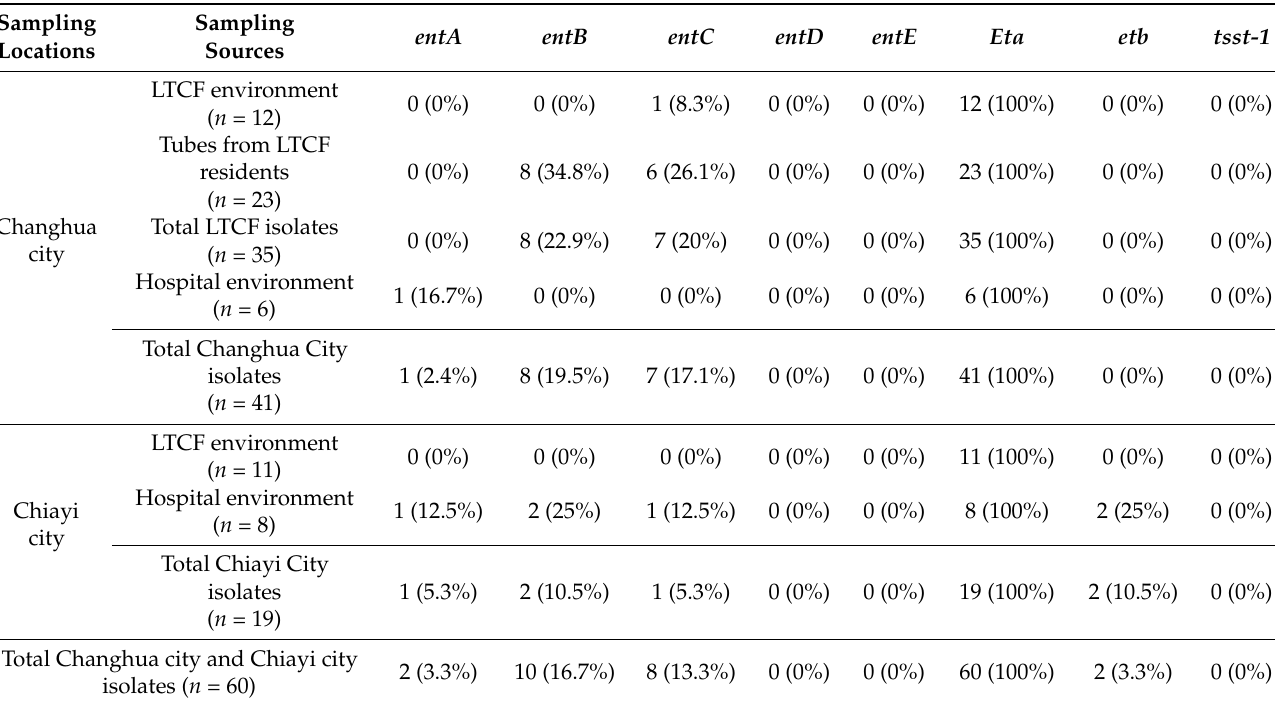
Table 3. PCR detection of toxin genes from the 60 MRSA